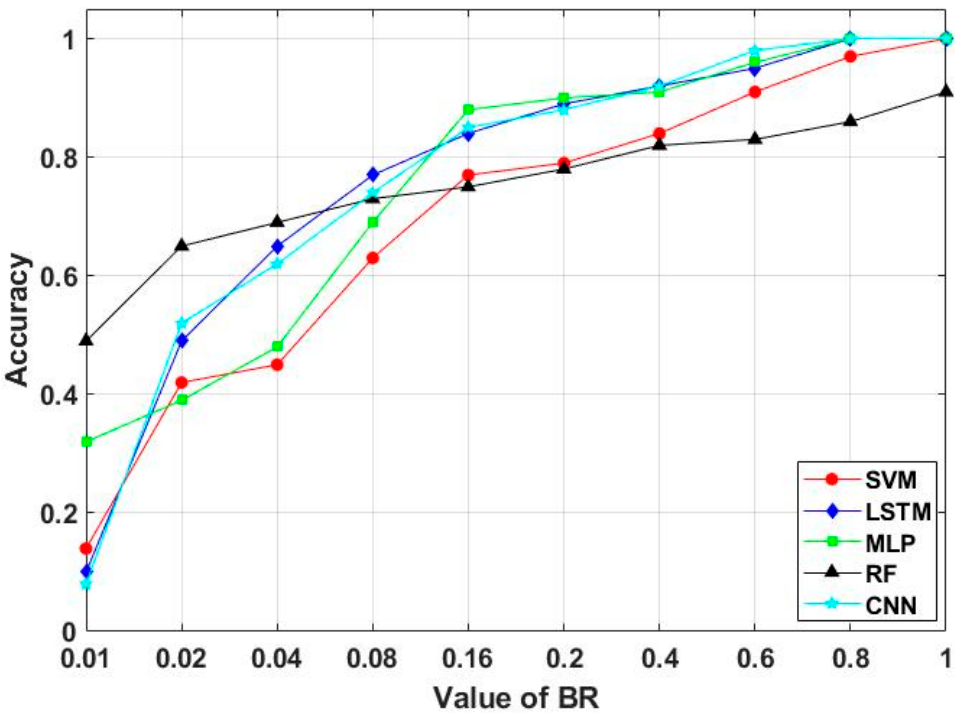
Figure 11. Relationship diagram between BR and accuracy of fault diagnosis methods.